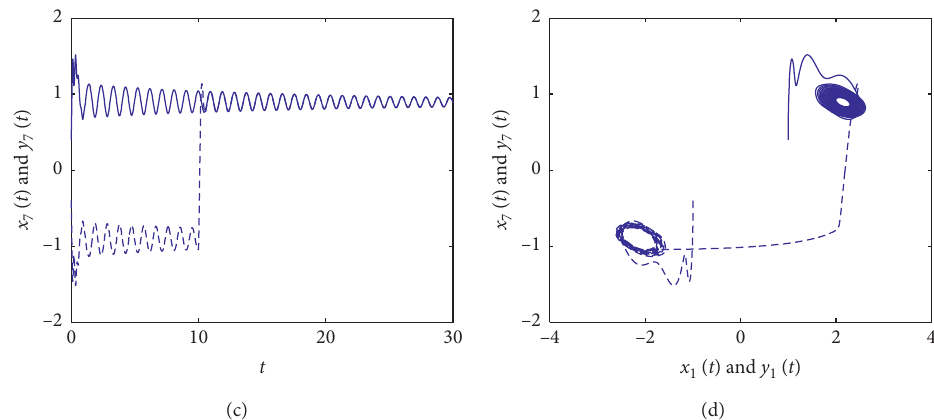
Figure 9: A static sliding mode control of an asymptotically stable orbit at the Reynolds number R symmetrized asymptotically stable state regime at R e � 20 in the master system (7). The controller is switched on at time t � 10. (a) The L ( t ) and y ( t ) versus time. (c) The states x norm of the error e versus time. (b) The states x 1 1 y ( t ) versus x ( t ) and y ( t ) showing how the controller drives the states from one attractor to another attractor. 7 1 1